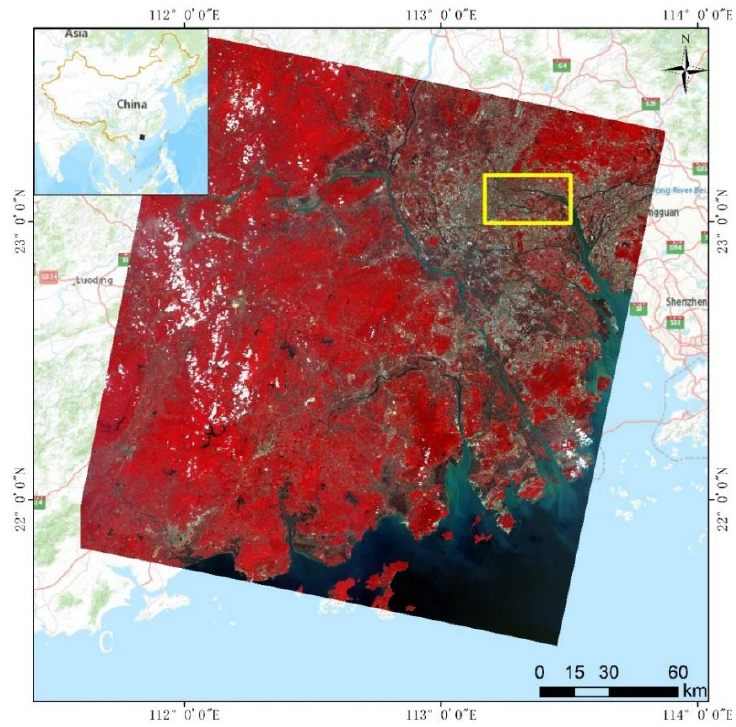
Figure 1. Map of the study area.